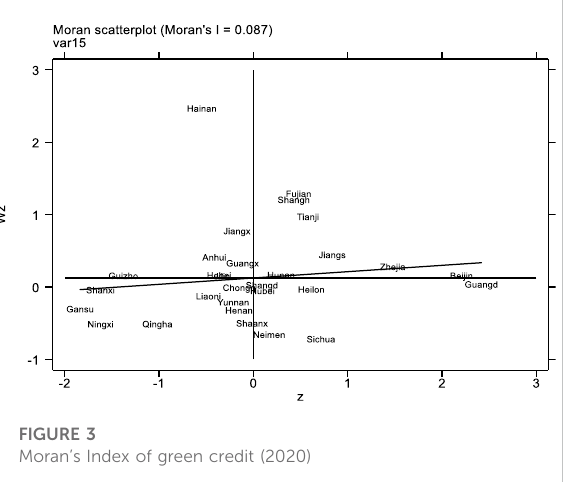
FIGURE 4 Moran ’ s Index of carbon emissions (2020)